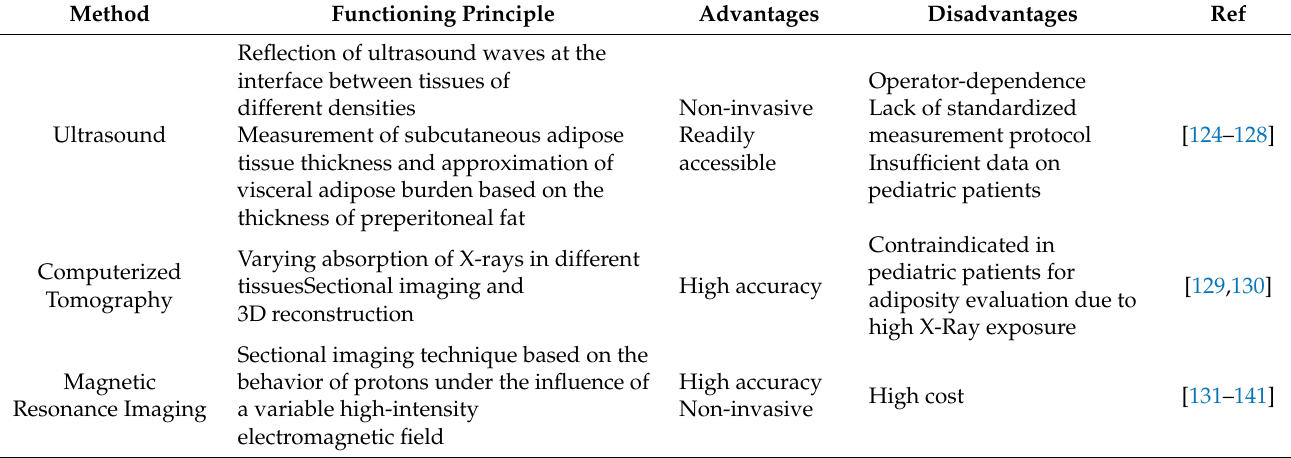
Table 3. Imaging modalities for evaluating